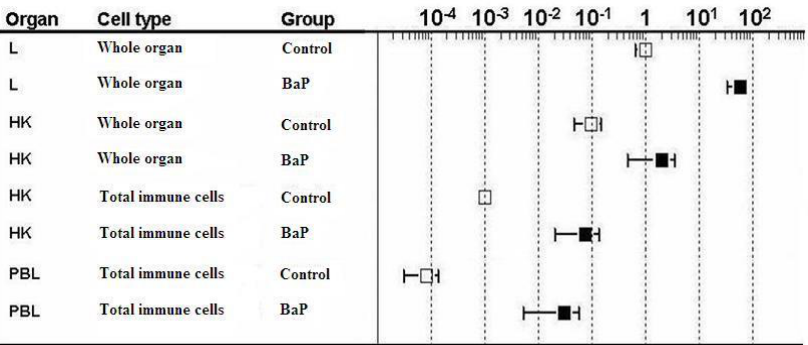
Figure 2. cyp1a gene expression levels of liver (L), head kidney (HK), immune cells isolated from head kidney and immune cells isolated from peripheral blood (PBL). The immune cells were not sorted but the total population was used. The RT-qPCR data were calculated using the 2 −(∆∆ct) method. Gene expression levels of the liver of control rainbow trout were set to be 1 and the mRNA expression levels of the other treatments were expressed relative to the control liver (note: log scale on the top x -axis). Data represent mean values ± SD from 10 fish per treatment. PBL = peripheral blood immune cells. Table 1. Induction of cyp1a mRNA transcripts in organs and cells of BaP-exposed rainbow trout relative to cyp1a transcript levels in the respective organs and cells of control rainbow trout.